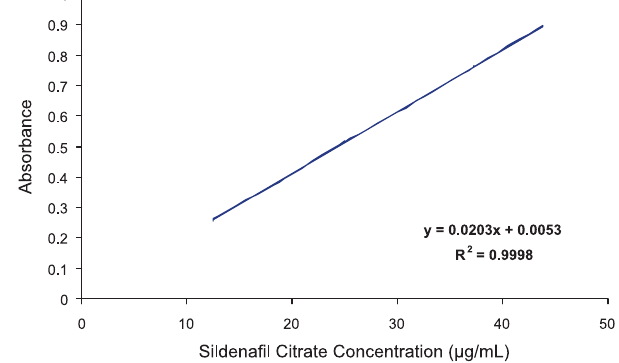
FIGURE 1 - Standard curve of determination of Sildenafil Citrate Content using the spectrophotometric